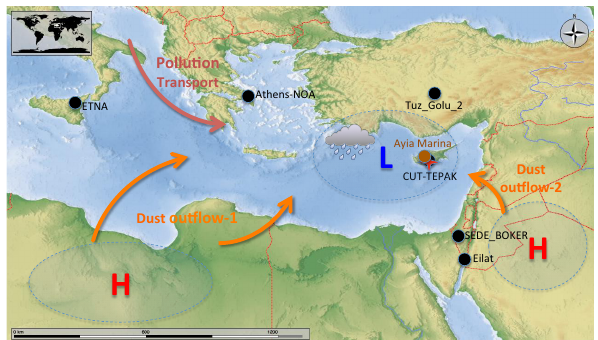
Figure 1. Schematic representation of the prevailing synoptic con- ditions. Cyprus low, main transport pathways for dust (orange) and air pollution (red) during both dust outflow event to the EM. Obser- vational stations are included: AERONET (black), EMEP station Ayia Marina (brown).